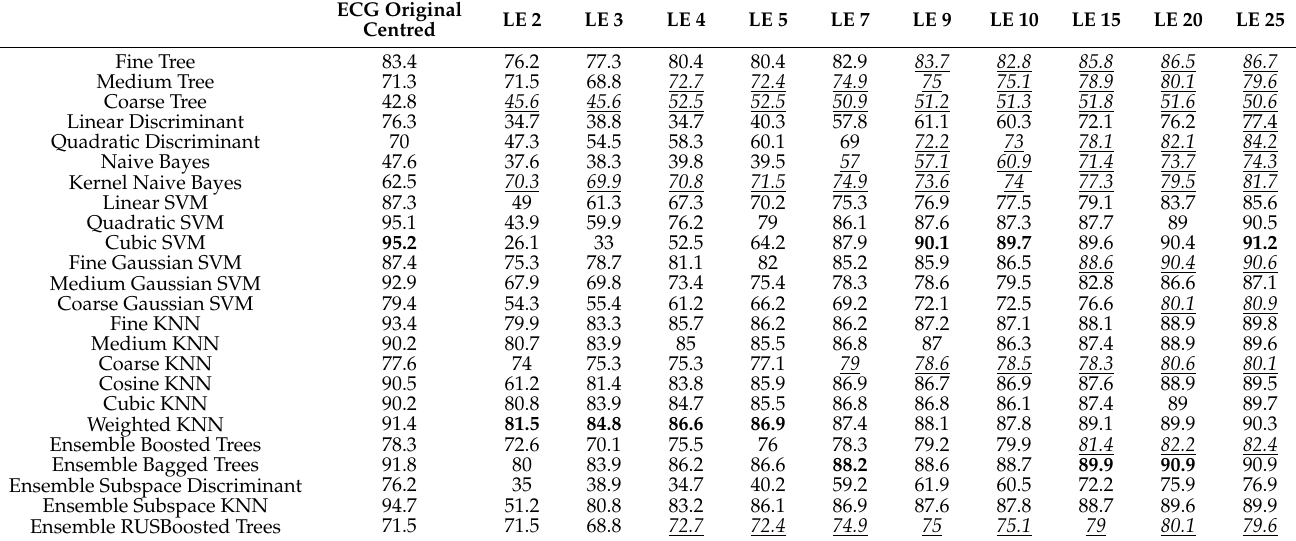
Table 3. Classification results with LE method for dimensionality reduction.